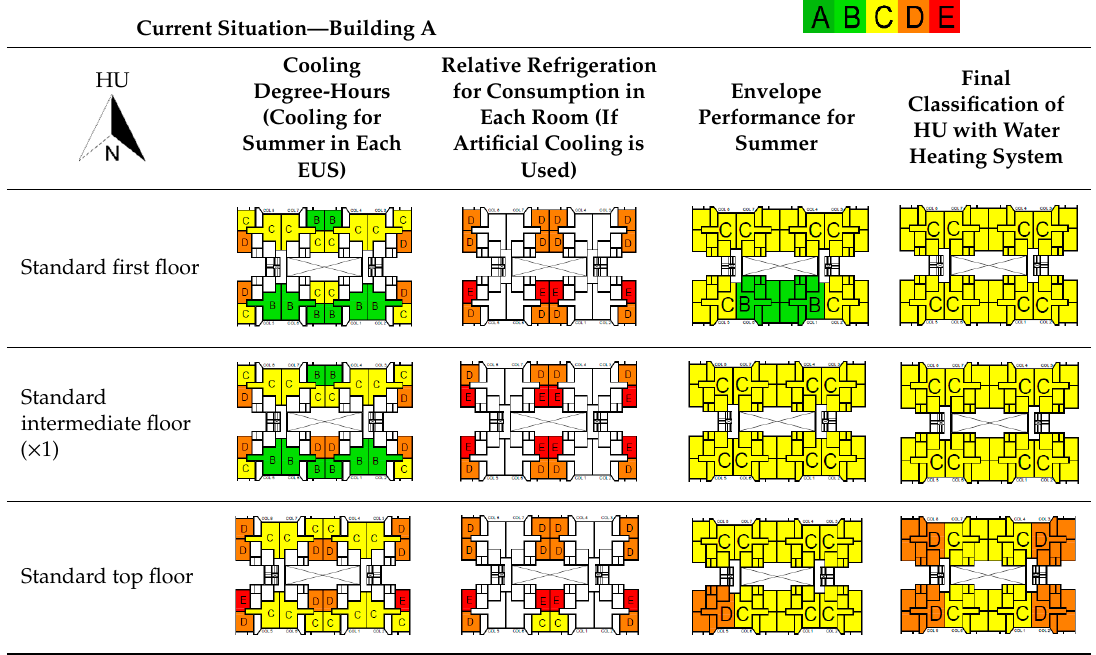
Table 5. Graphical representation of the standard floor of Representative Building A with the classification based on energy efficiency assessment.